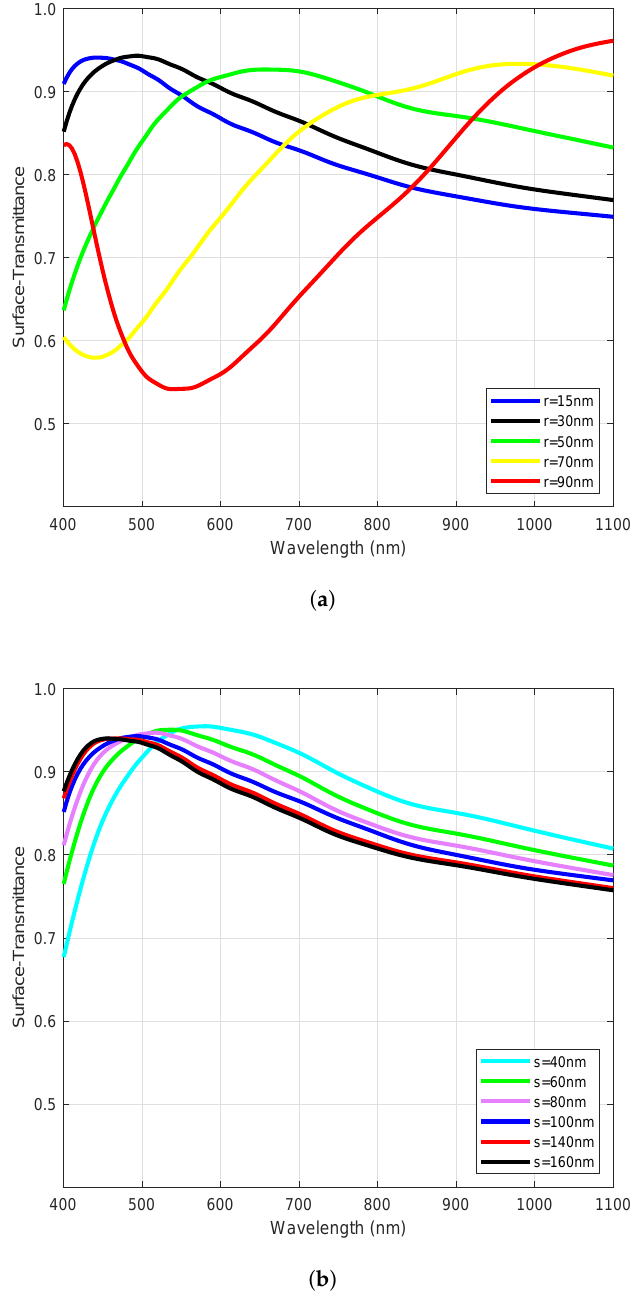
Figure 6. Front surface transmission with Al nanoparticle for ( a ) fixed spacing s = 100 nm ( b ) fixed radius r = 30